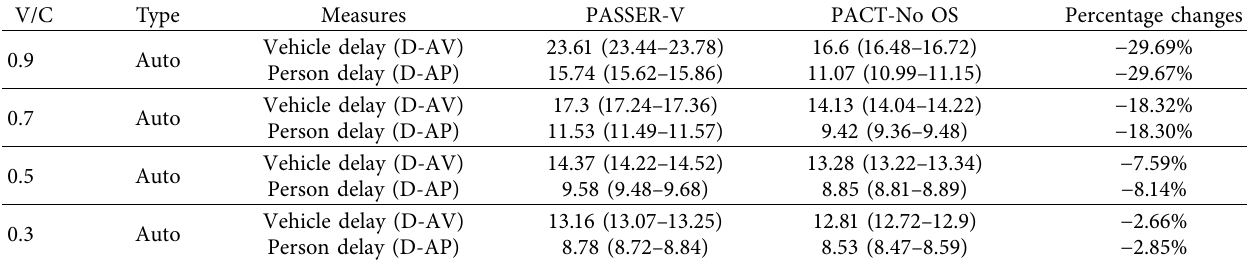
Table 2: Person-based and vehicle-based delay results without buses under various V/C ratios.